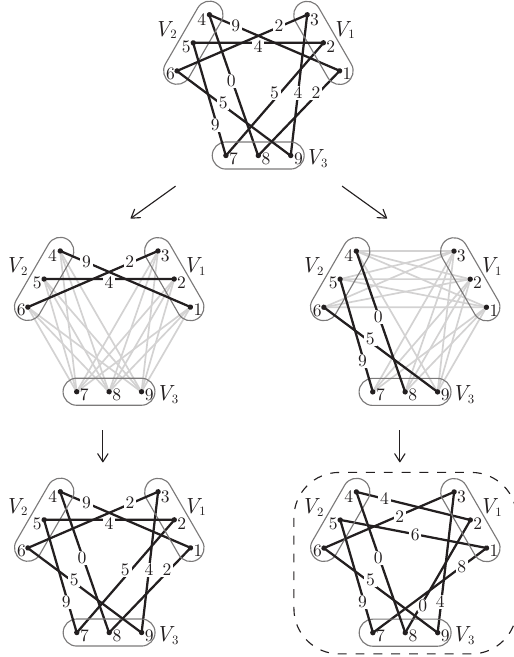
Figure 3. Cases for Algorithm C m